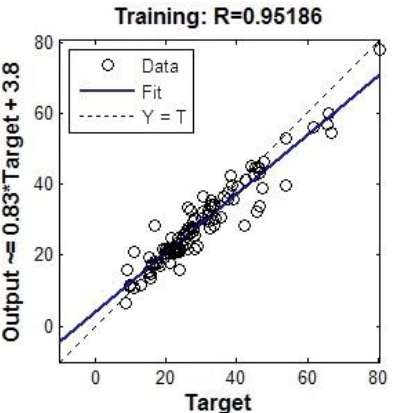
Fig. 14. Relationship between Target and Output Values in Training Step of ANN Modeling with 17 Hidden Neurons.